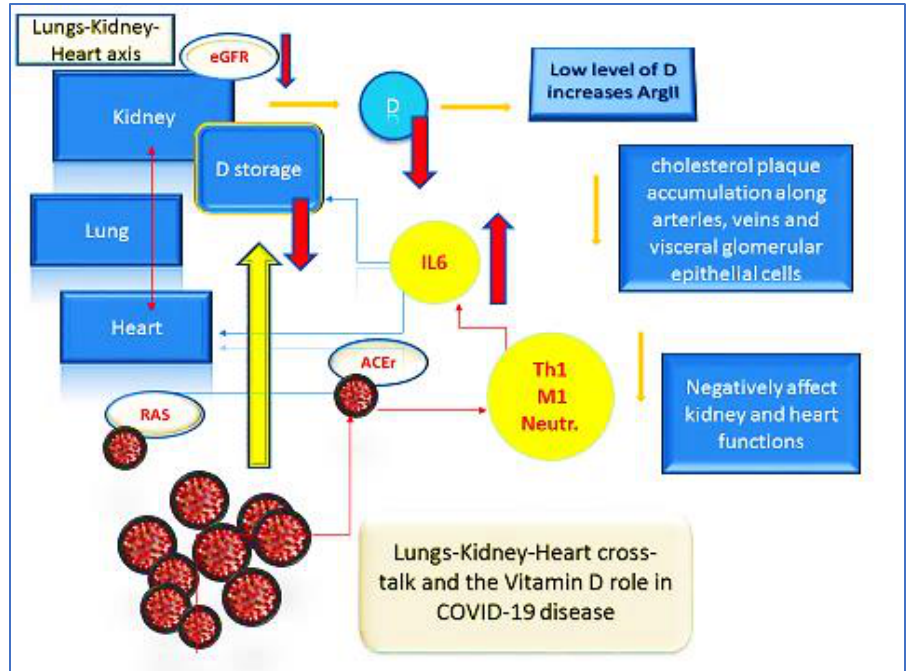
Figure 7. The regulation of acid–base equilibrium; modification of partial pressure of carbon dioxide, oxygen, and bicarbonate concentration; and the control of blood pressure, fluid homeostasis, and systemic blood supply all closely depend on renal and heart pulmonary activities. SARS-CoV-2 dangerously spreads prevalently, due to the low level of vitamin D as crucial mediator of the Ang-II production within the RAS and the angiotensin-converting enzyme 2 receptor (ACE2R) and the angiotensin-converting enzyme 2 mechanism (ACE2/ACE2r). The entire sequence of COVID-19-related complications starts via the downregulation of ACE2r expression as the SARS-CoV-2 main entrance. The Ang-II high accumulation induces uncontrolled hyper-inflammatory responses led by the IL-6 scenario that has been seen as prerogative cause of acute heart and renal failures particularly witnessed in elderly people or in patients with preexisting metabolic comorbidities. The totality of adverse effects related to Ang-II eases cholesterol plaque accumulation along vases and visceral glomerular epithelial cells (podocytes) that provoke systemic and glomerular hypertension or cause ischemia-induced renal injury, which results in kidney and cardio-vascular failures (figure by C. Gargiulo Isacco).